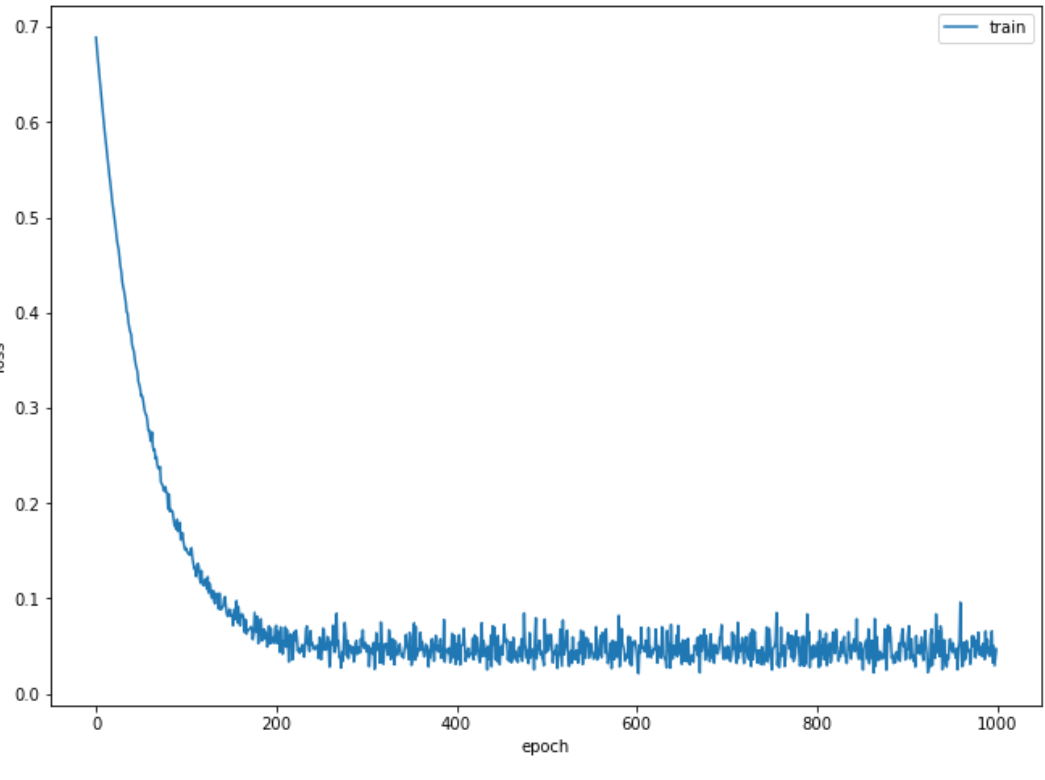
Figure 6. Gully erosion convolutional neural network (GECNN) neural network training graphics.